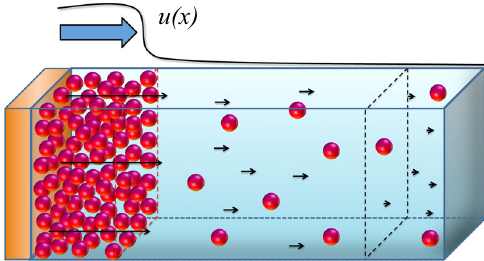
FIG. 1. Schematic representation of the shock-wave evolution. The orange region indicates the metallic electrode, and the blue indicates the TMO dielectric. Small spheres denote the ionic defects (oxygen vacancies) whose density profiles form a shock wave. It evolves through a highly resistive (Schottky) interface and eventually leaks over the more conductive bulk, producing the resistive change. Black arrows depict the strength of the local electric